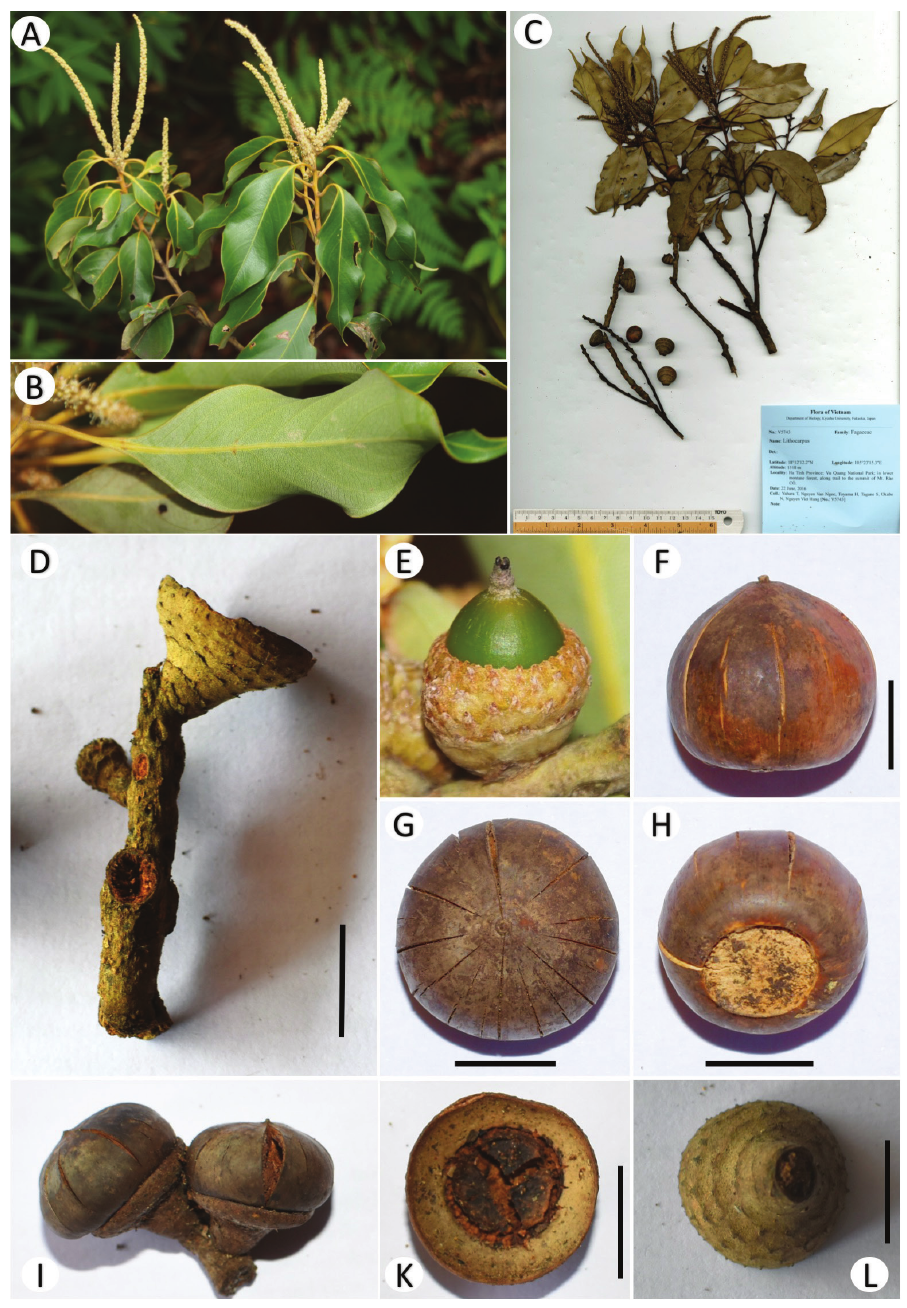
F igure 3. Lithocarpus vuquangensis Ngoc & Hung: A Branch with male inflorescences B Lower leaf surface C Holotype (KYO) D Spike with cupule E Young acorn F–H Side view, top view and scar of the mature nut, respectively I A part of infructescence K , L Inside and outside of the cupule. C, D, F – L From Yahara et al. V5743 . Scale bars: 2 cm ( D ), 1 cm ( F – H, K , L